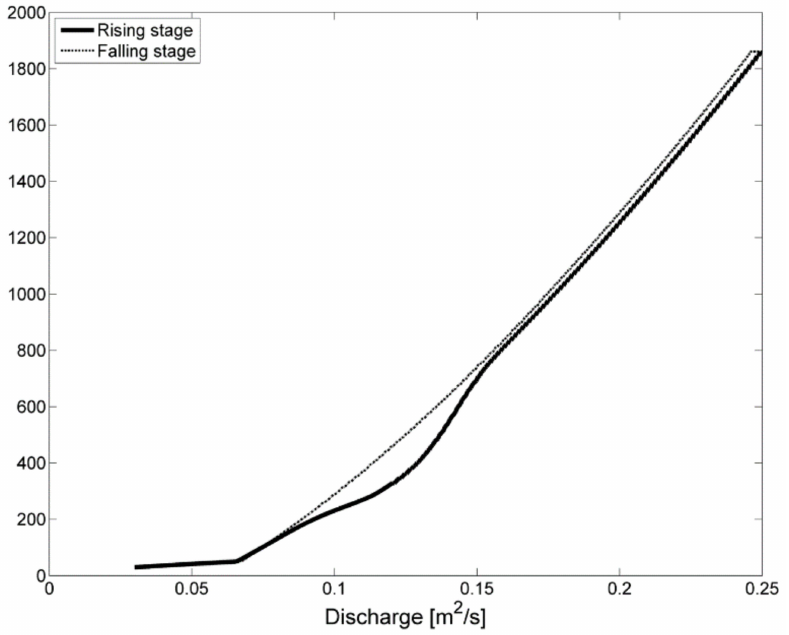
Figure 8. Specific discharge versus non-dimensional step length α separated for the rising and falling stages of the hydrograph.